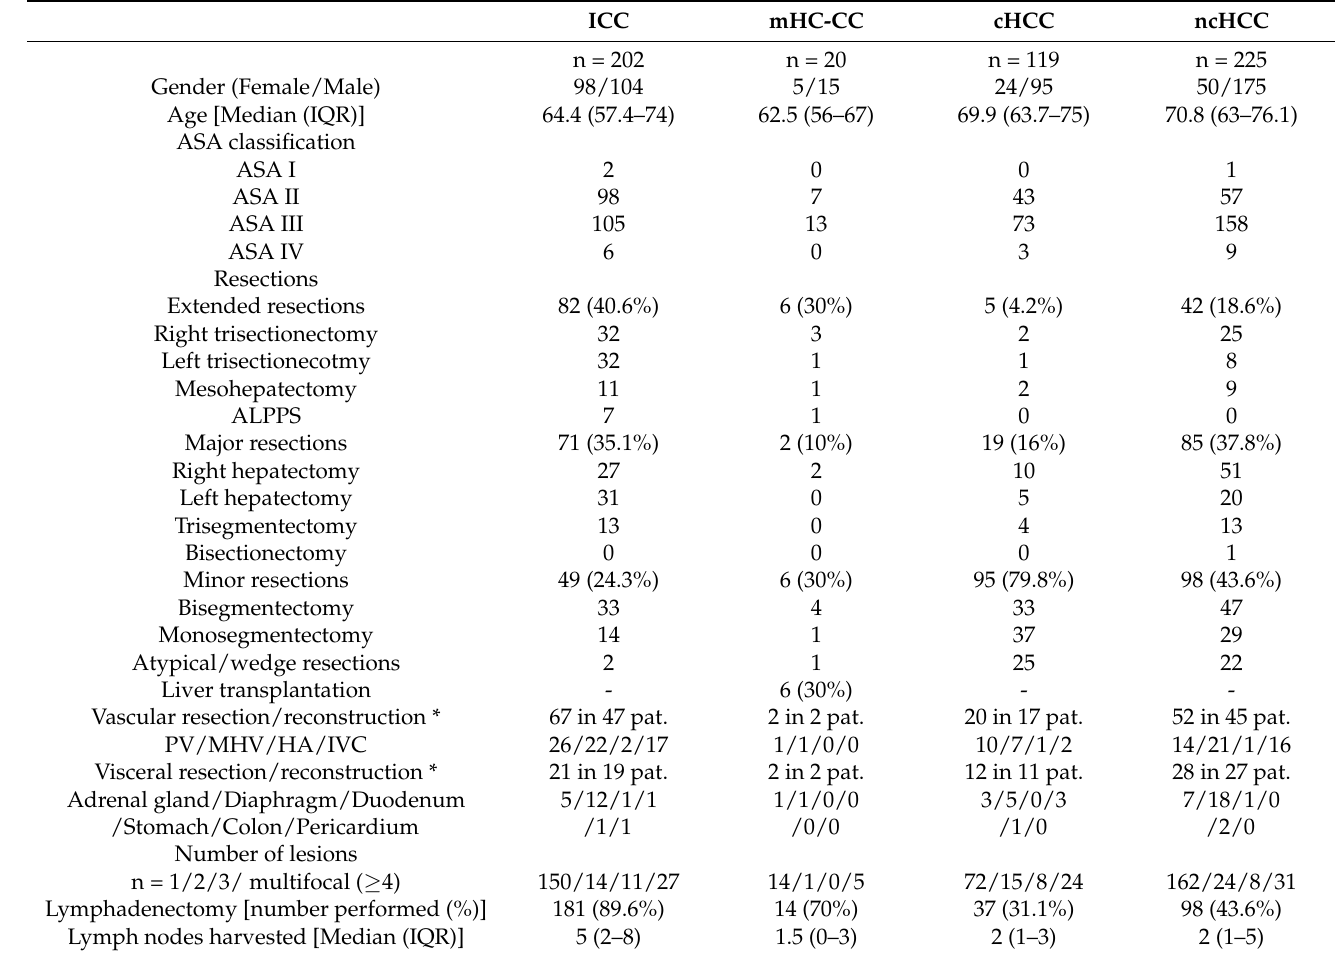
Table 1. Baseline characteristics and surgical data.